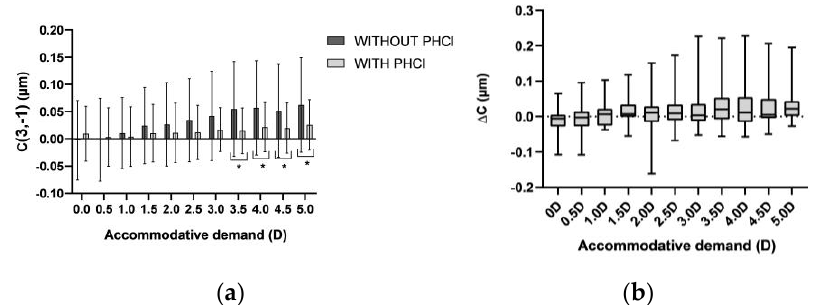
Figure 3. ( a ) Zernike vertical coma coefficients for the different accommodative demands, before and after the instillation of PHCl (grey and black bars, respectively). ( b ) Box plot of the difference in Zernike coefficients between natural conditions and after instillation of PHCl for each accommodative demand. * Denote statistically significant values ( p < 0.05). Error bars represent the standard deviation